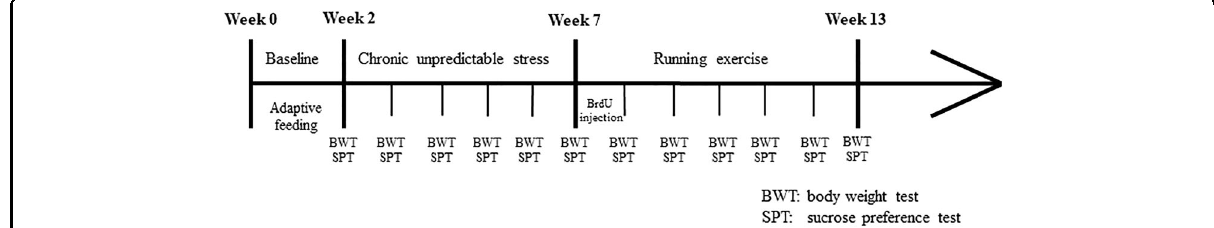
Fig. 1 Behavioral experiment timeline. The experiment lasted a total of 13 weeks. The animals were allowed to habituate to the housing conditions for 2 weeks before any experiments were initiated. The CUS rats were subjected to a sequence of 10 different stressors (two stressors per day for 5 weeks). The animal in the CUS/running group ran on a six-lane motorized treadmill for 6 weeks after CUS. Body weight and sucrose preference were assessed each weekend. CUS chronic unpredictable stress, BWT body weight test, SPT sucrose preference test.